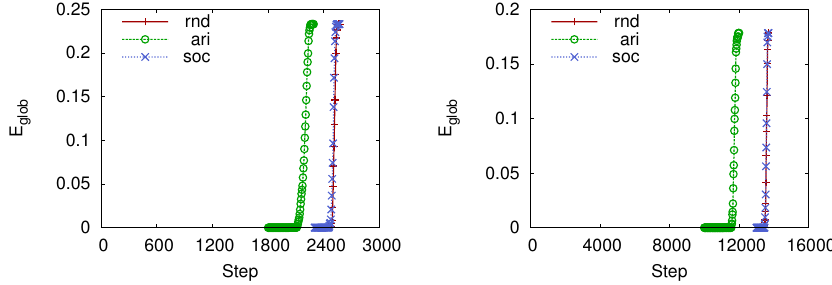
Figure 9. Effect of simultaneous network simulation in randomized version of Communities ( left panel ) and VirtualTourist ( right panel ). Curve starts at simulation time t 0 , but we cropped the points for low values of E glob for graphical clarity. Standard deviation is very small and therefore is not